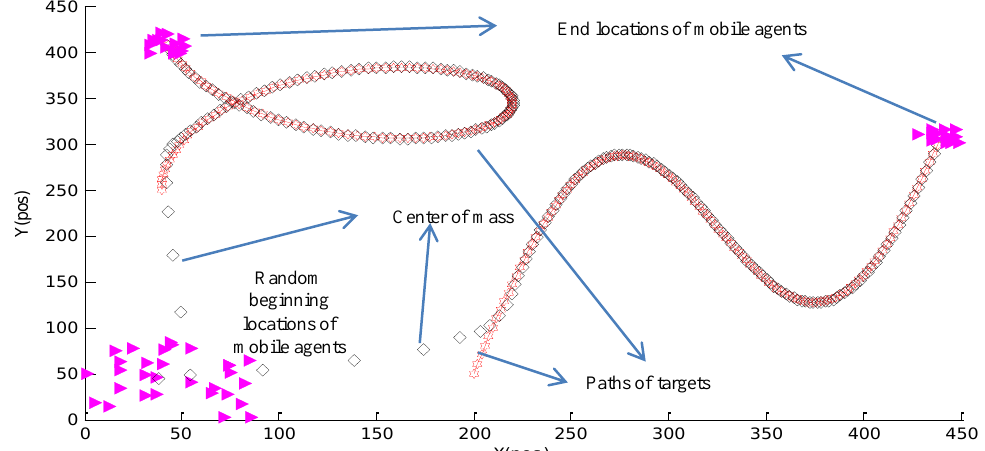
Figure 4. Beginning and ending locations of 30 mobile agents that are following two dynamic targets in semi-circular and semi-sine wave paths with optimal parameters in table 1 by proposed flocking control algorithm using (11) and GSA.